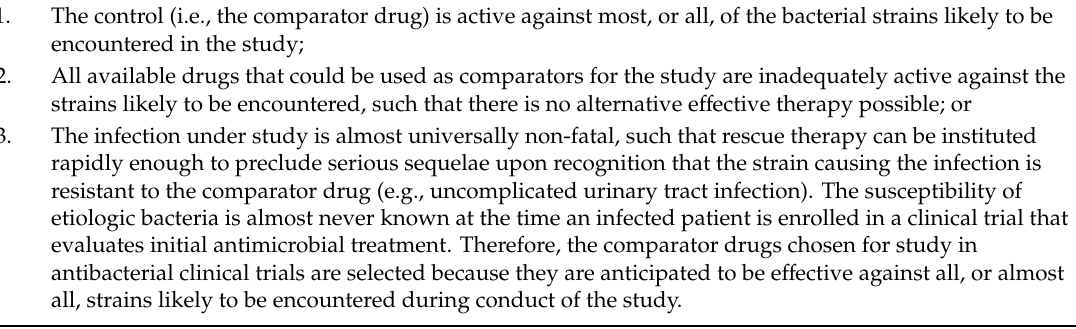
Table 4. American Society of Infectious Diseases criteria for ethical active-controlled superiority studies of antibacterial